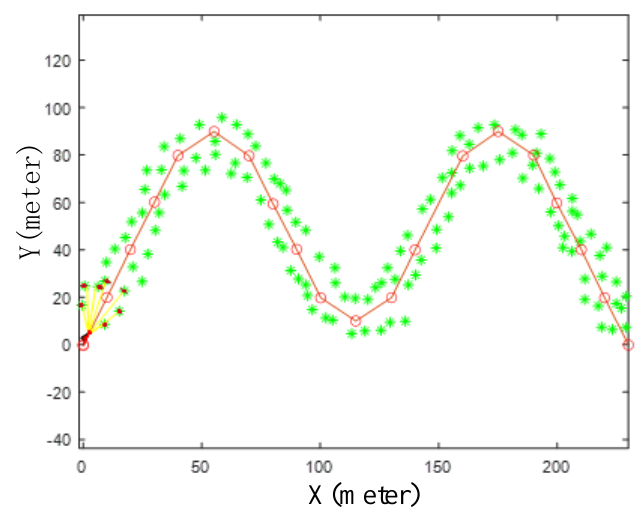
Figure 3. Simulation Environment.